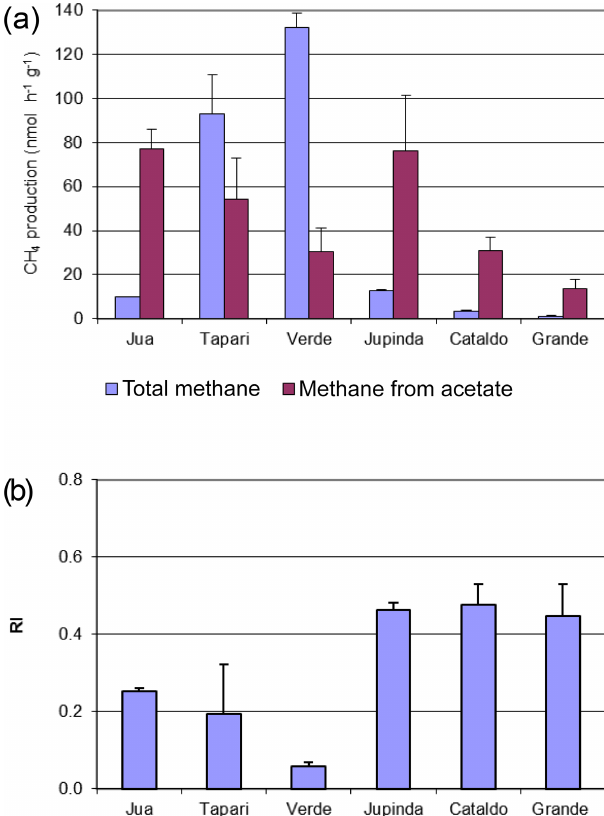
Figure 4. (a) Rates of total and acetate-derived CH 4 production in sediments of different Amazonian lakes and (b) respiratory indices (RI) of the turned-over 2- 14 Cacetate (mean ± SE).